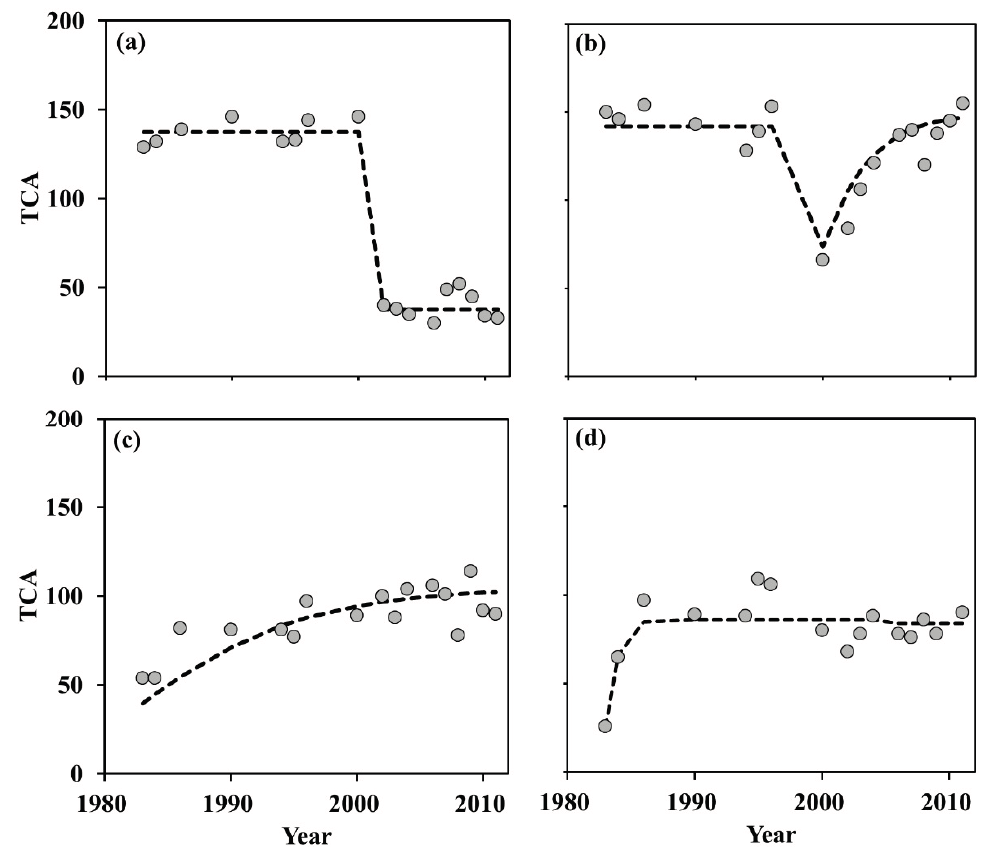
Figure 2. Example of the four disturbance class spectral trajectories and parameters fit to each trajectory. ( a ) disturbance, ( b ) disturbance followed by revegetation, ( c ) ongoing revegetation, and ( d ) revegetation to a stable state (After Ahmed et al.